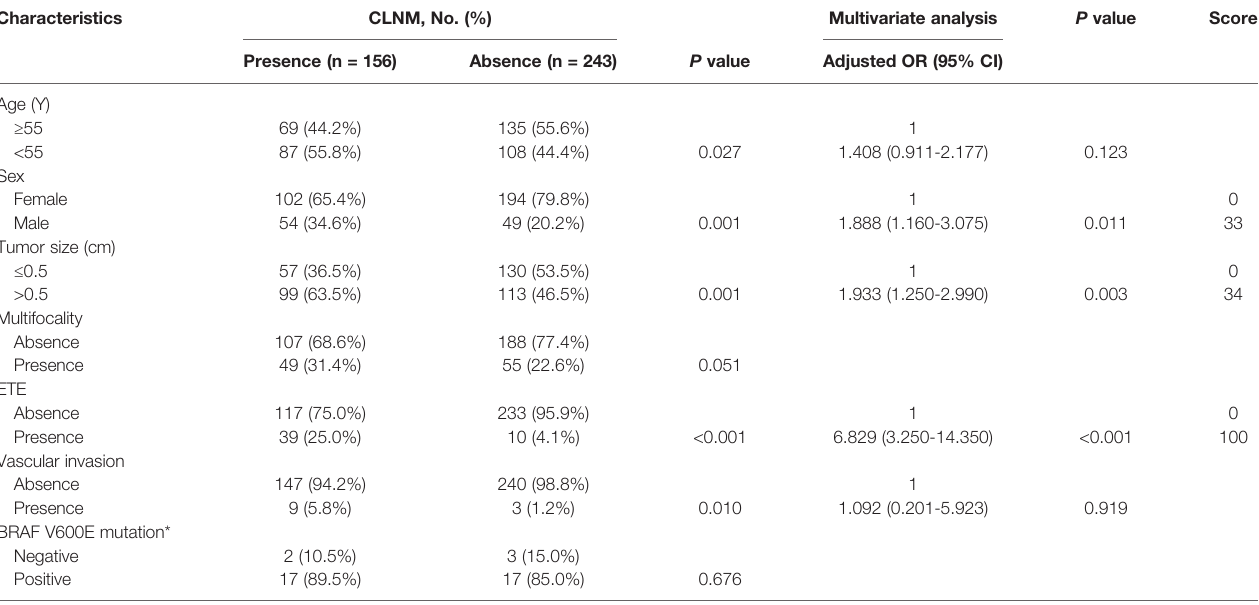
TABLE 1 | Univariate and multivariate analyses of factors associated with CLNM and score in patients with PTMC.